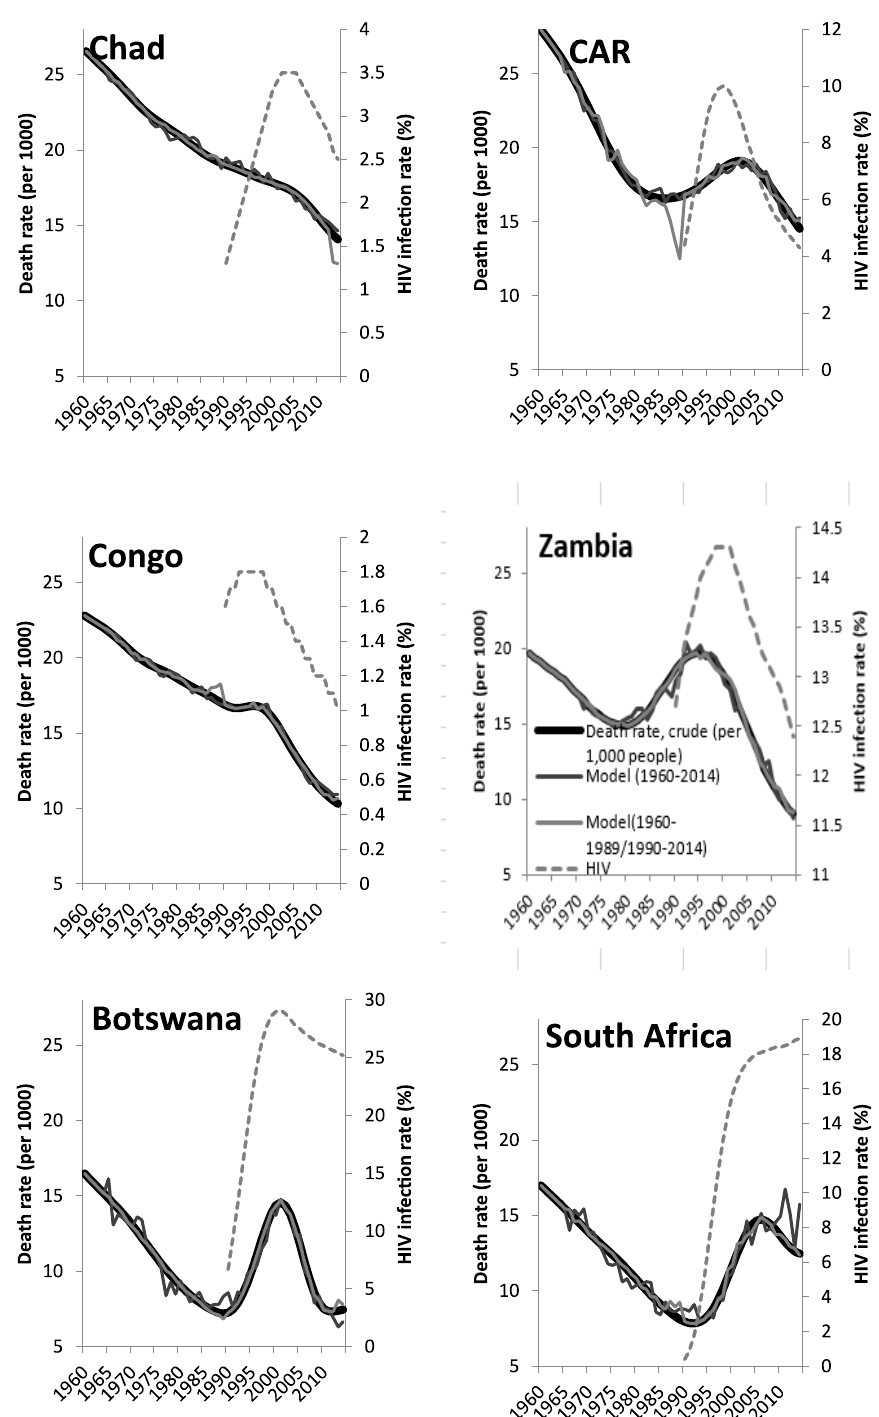
Figure 4. Panels show the death rate of the N-S transect countries (bold; except Libya), with the full period model (light grey), and the combined early and late period model (dark grey) fits. The HIV infection rate is dashed. See Table 1 for the sources of the data.